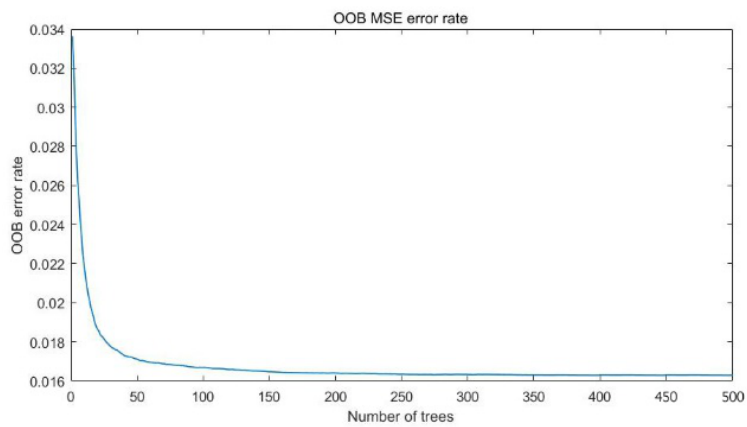
Figure 8. Out-of-bag (OOB) error rate of the susceptibility results.